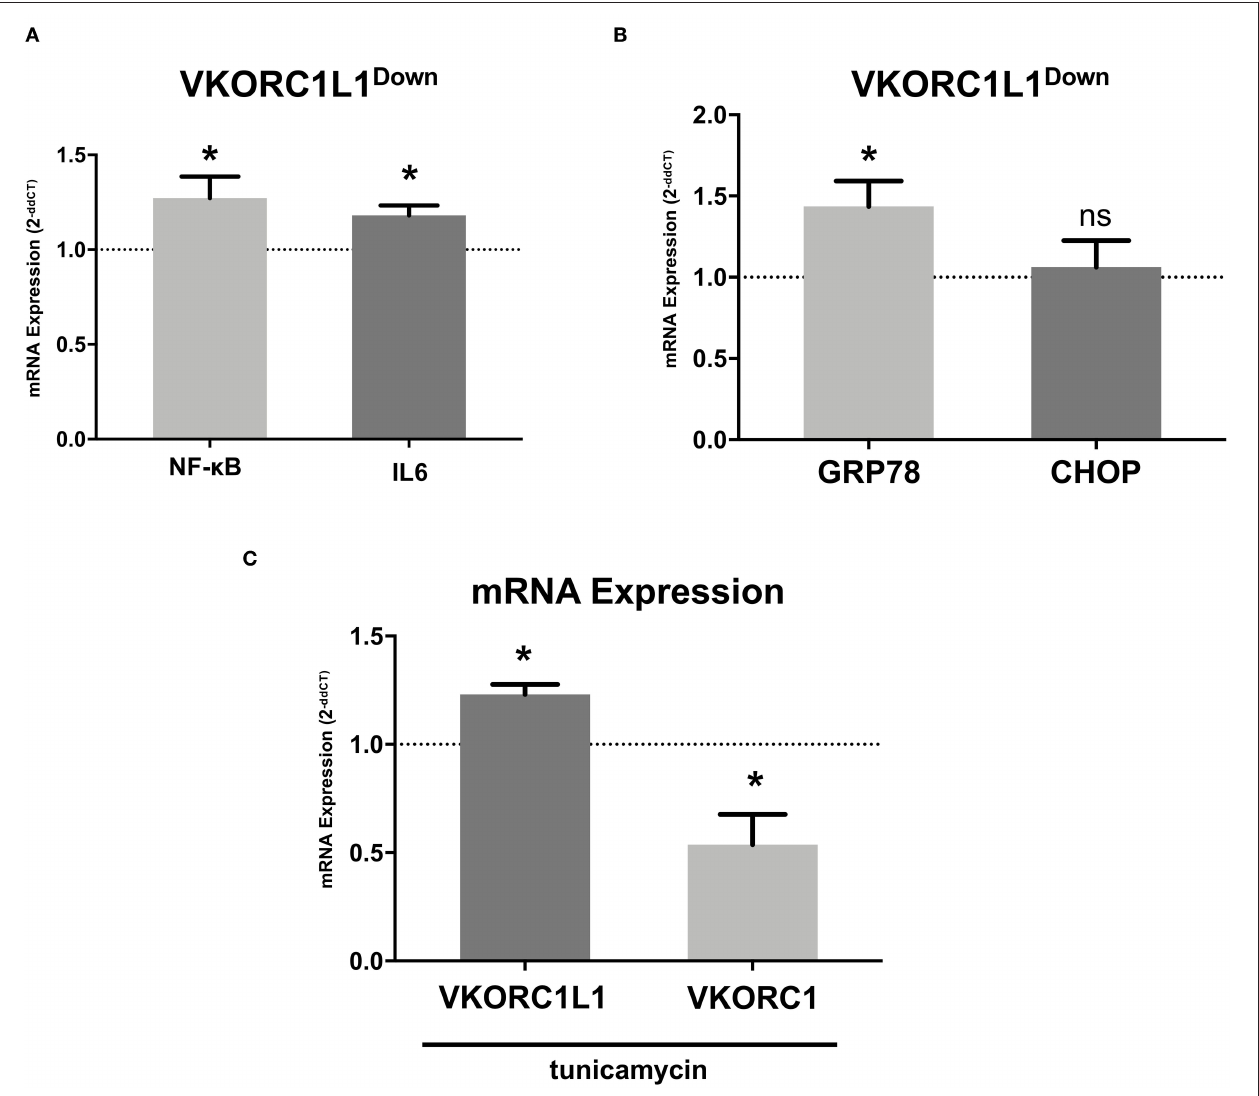
FIGURE 4 | VKORC1L1 regulates vascular inflammation. (A) mRNA expression of the pro-inflammatory markers NF- κ B and IL-6 in HCASMC after transfection with siRNAs directed against VKORC1L1 or a scrambled control. Control mRNA expression ( = 1) is shown as a dotted line. mRNA expression was measured by qPCR and quantified by the 2 − ddCT method. n = 3–8. (B) mRNA expression of ER stress markers GRP78 and CHOP in HCASMC after transfection with siRNAs directed against VKORC1L1 or a scrambled control. Control expression ( = 1) is shown as a dotted line. mRNA expression was measured by qPCR and quantified by the 2 − ddCT method. n = 4–8. (C) mRNA expression of VKORC1L1 and VKORC1 in HCASMC after treatment with the ER stress inductor, tunicamycin (6h, 5 µ g/ml). Control expression (DMSO treatment, = 1) is shown as a dotted line. n = 4. Data are presented as the mean ± SEM; * p < 0.05. Unpaired t -test for (A-C)